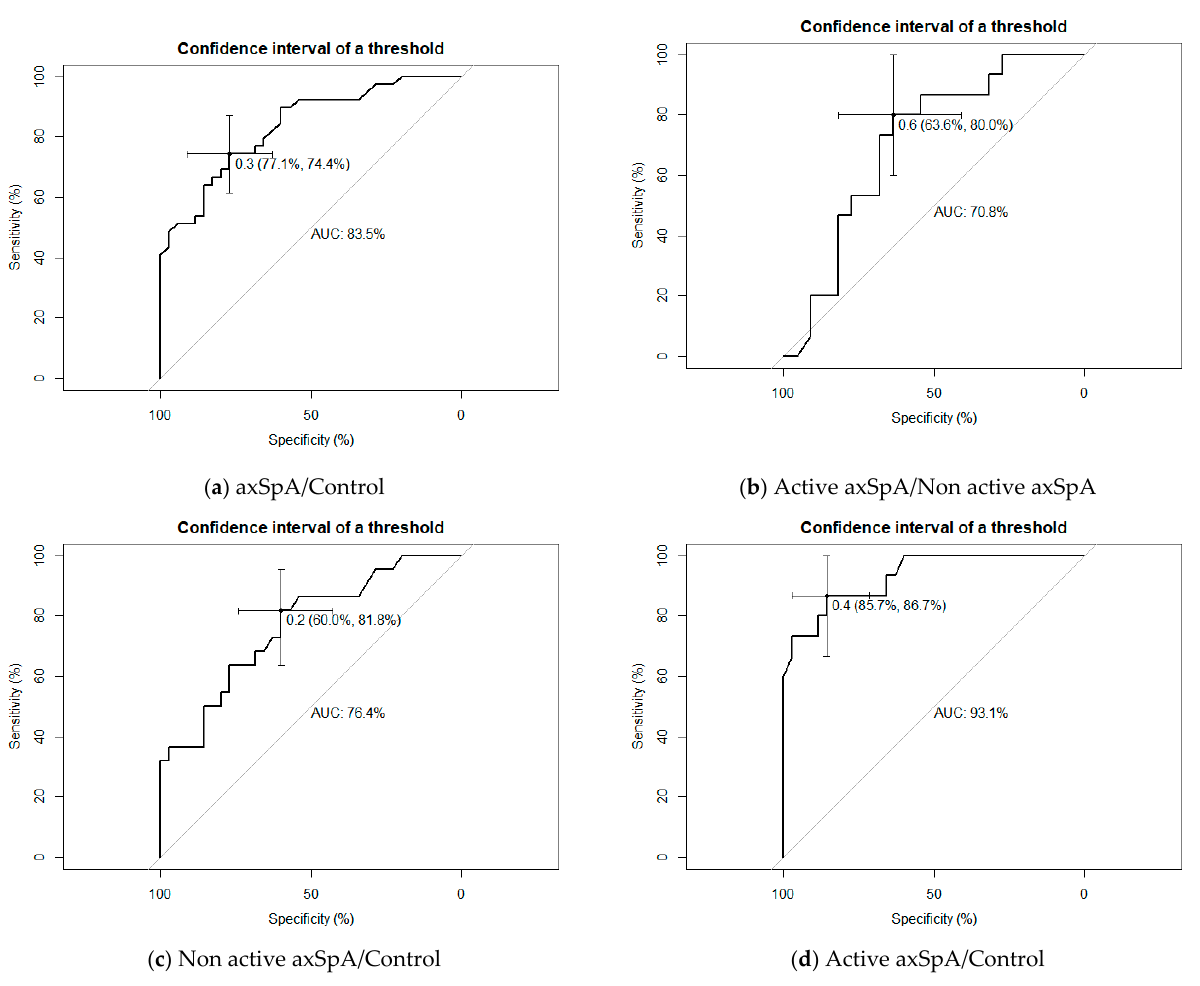
Figure 3. ROC analysis using 1/FRR to distinguish axSpA patients and healthy controls.